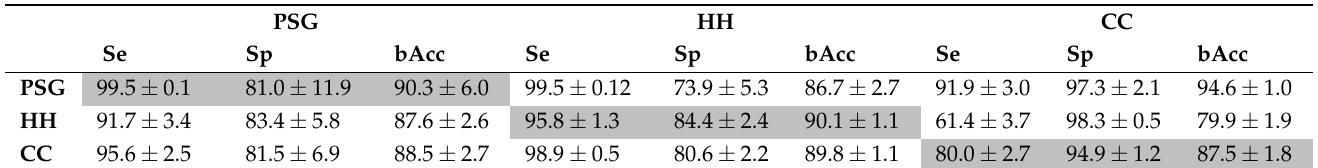
Table 2. Results obtained for the base classifiers. The columns indicate the training datasets and the rows the test datasets. The cells in grey indicate the intra dataset results when using fivefold cross-validation. The other cells indicate the inter dataset results, averaged over 25 folds. In other words, when the classifier is trained on five training sets and, each time, applied on the five testing sets of the other datasets. The results are shown as mean ± standard deviation.